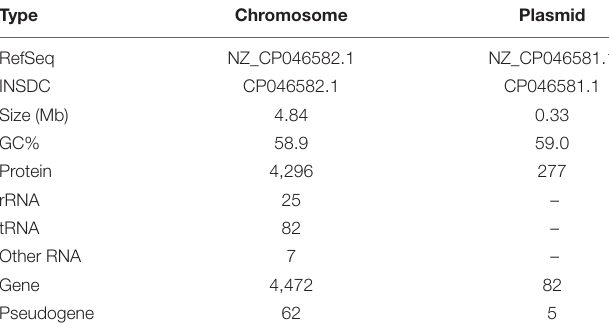
TABLE 1 | Summary of Erwinia sp. E602 genome